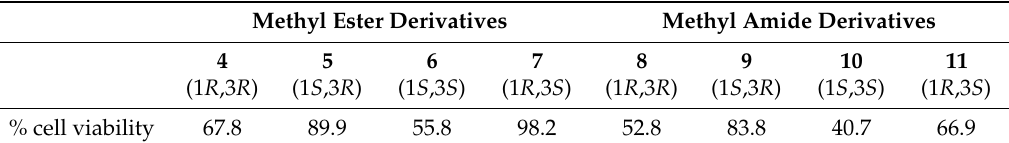
Table 1. Percent (%) Cell viability of 4 – 11 at 165 µM using the WST-8 method. Methyl Ester Derivatives